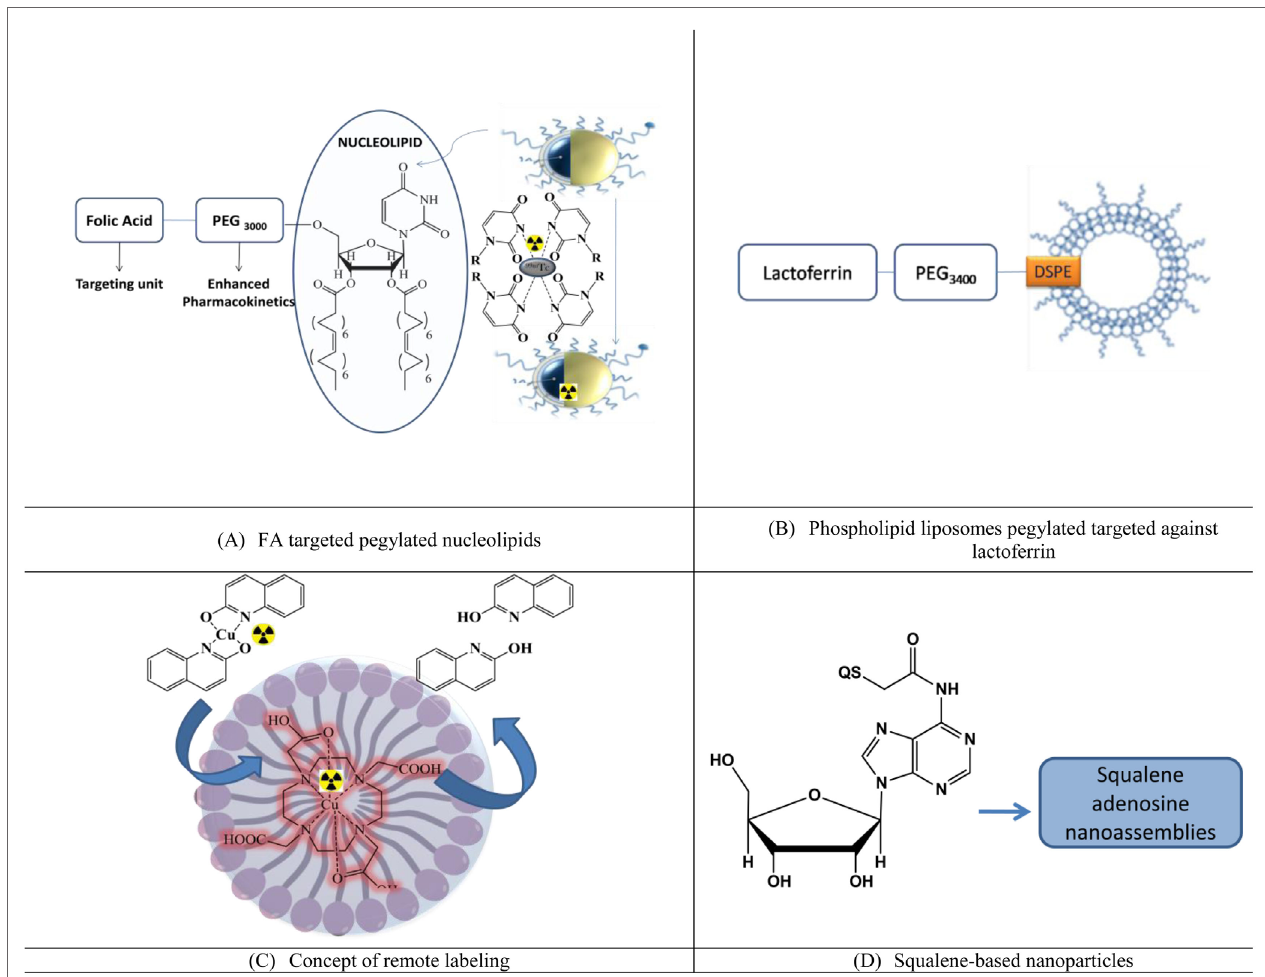
FiGURe 4 | Lipidic nanoparticles for imaging and enhanced pharmacokinetics. (A) FA targeted pegylated nucleolipids, (B) phospholipid liposomes pegylated targeted against lactoferrin, (C) concept of remote labeling, and (D) squalene-based